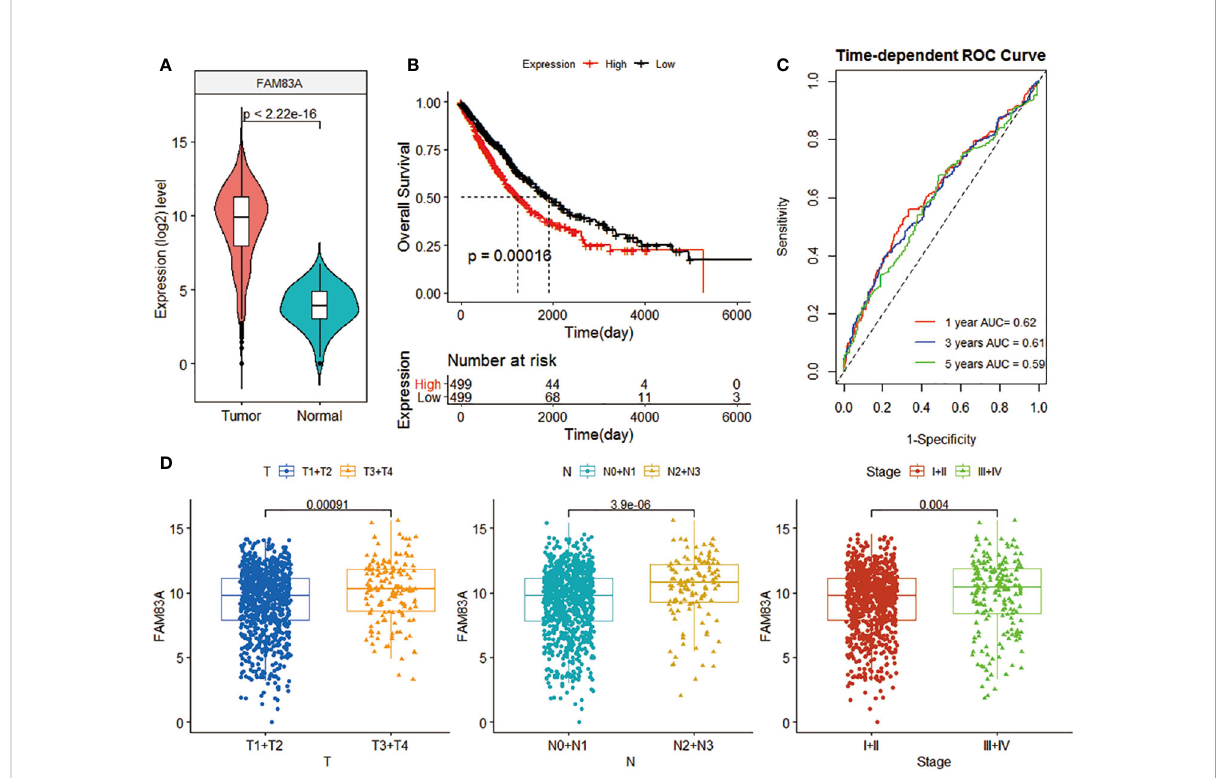
FIGURE 1 The clinical bene fi t of FAM83A gene expression level. (A) Violin plot of FAM83A expression levels in tumor and normal samples in the TCGA data set. (B) K-M curve related to FAM83A expression level and prognosis. The black and red curves refer to the low and high expression sample groups, respectively. (C) 1-, 3-, and 5-year ROC curves based on the FAM83A expression. (D) Box plot of the correlation between FAM83A expression level and T, N, and